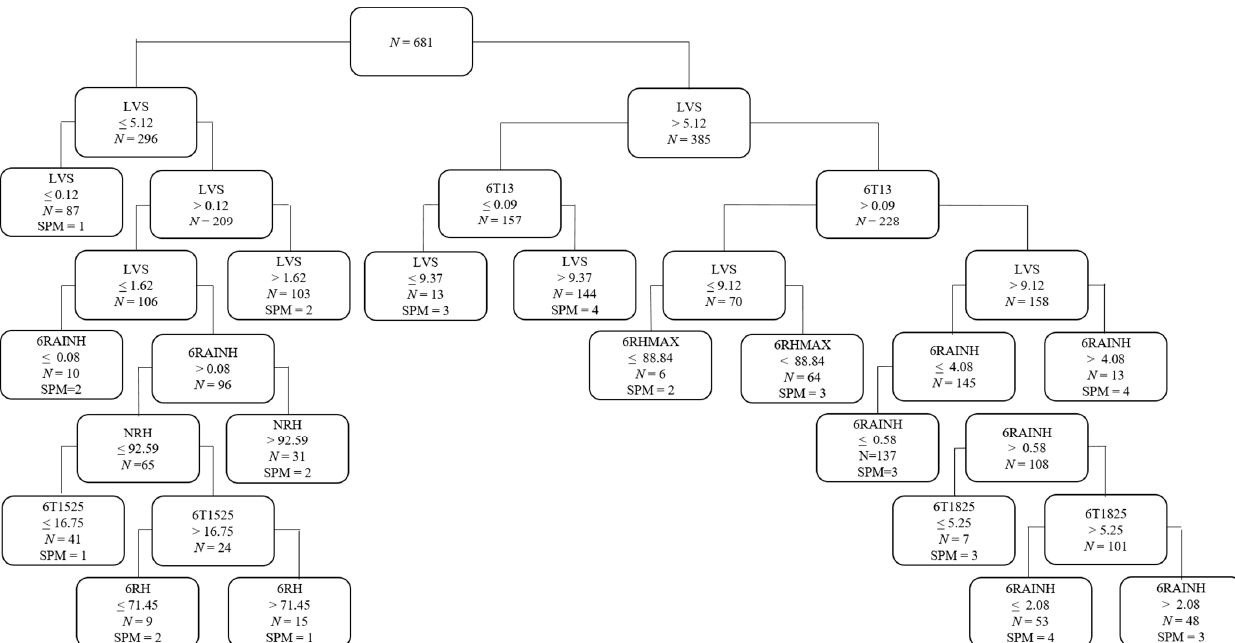
Figure 6. Representation of the classification tree built with number of susceptible leaves (LVS), mean number of hours at temperature above 13 °C during the previous six days (6T13), mean elative humidity during the previous six days (6RH), mean number of rainy hours during the previous six days (6RAINH), mean number of hours at temperature between 15 and 25 °C during the previous six days (6T1525), and mean maximum relative humidity during the previous six days (6RHMAX).